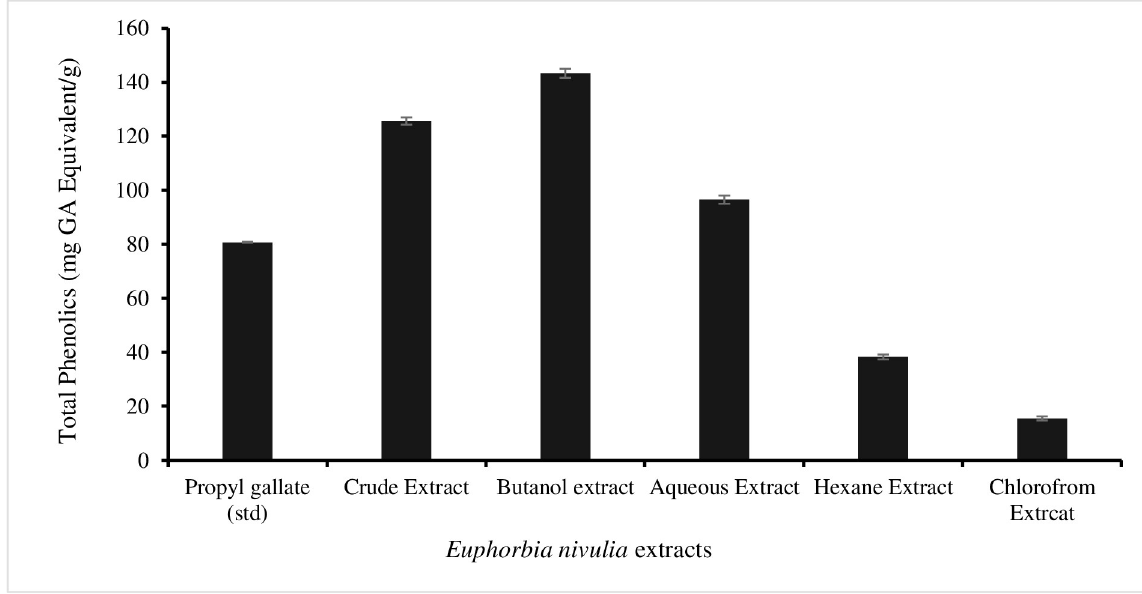
Fig 2. Total phenolic contents in Euphorbia nivulia Buch.-Ham. crude extract and various fractions.